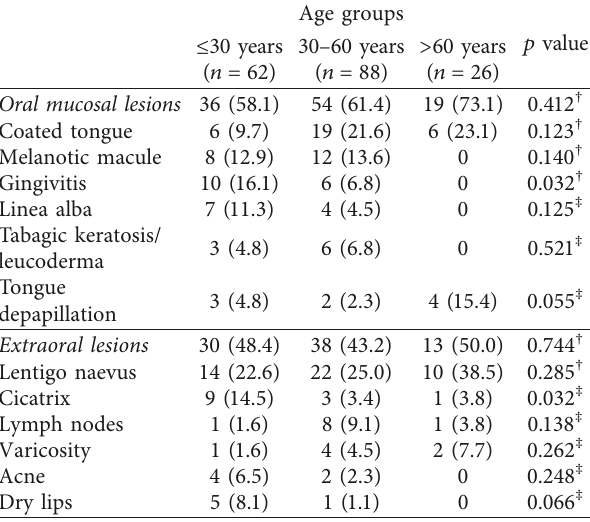
Table 6: Most frequent extraoral and intraoral lesions by age